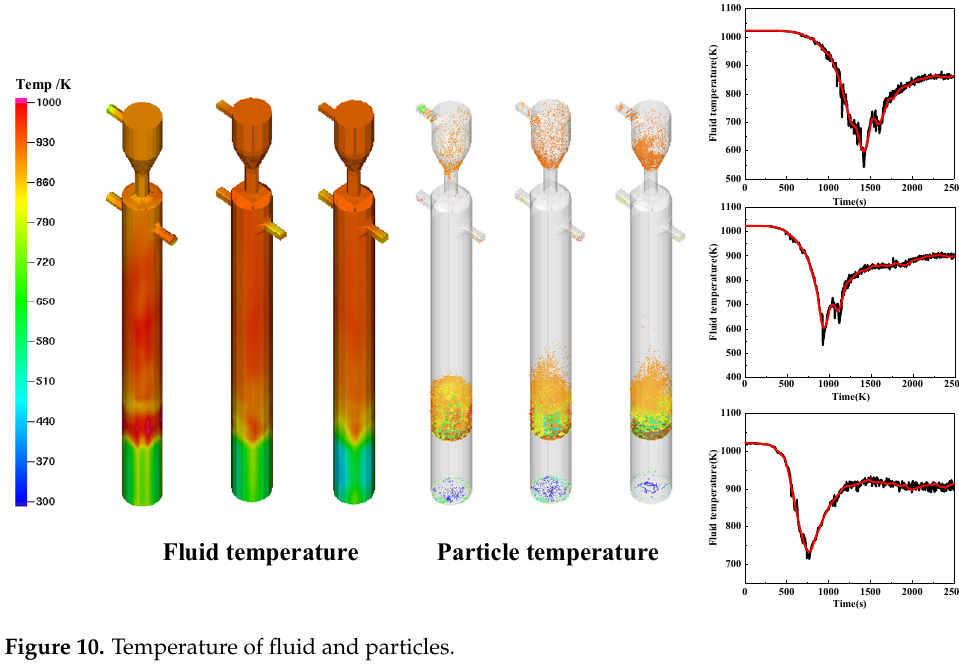
Figure 10. Temperature of fluid and particles.